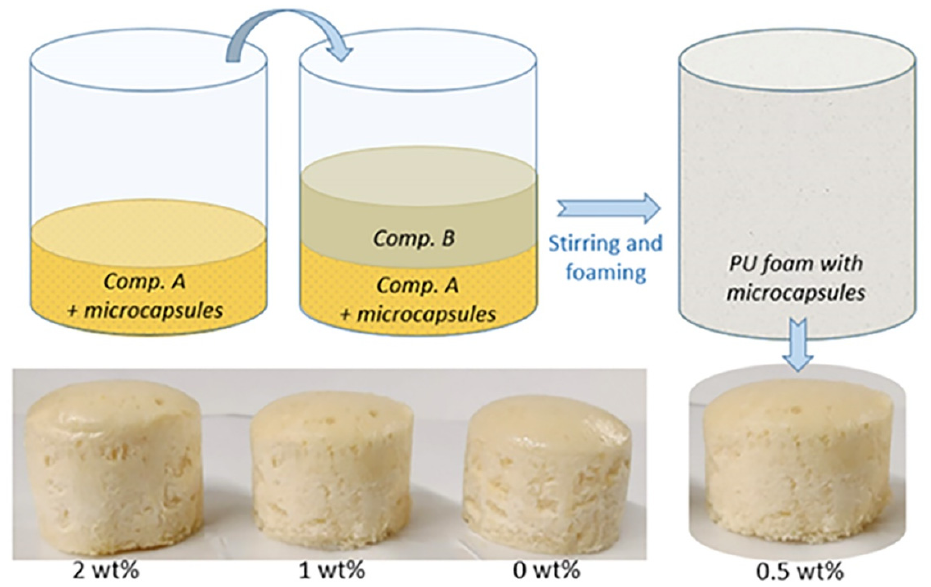
Figure 2. Scheme of the foaming process with embedding of microcapsules and fabricated PU cylindrical foams.